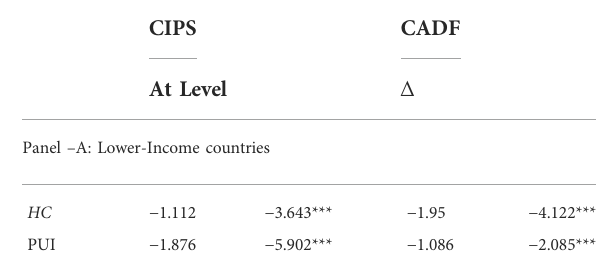
TABLE 3 CIPS and CADF unit root